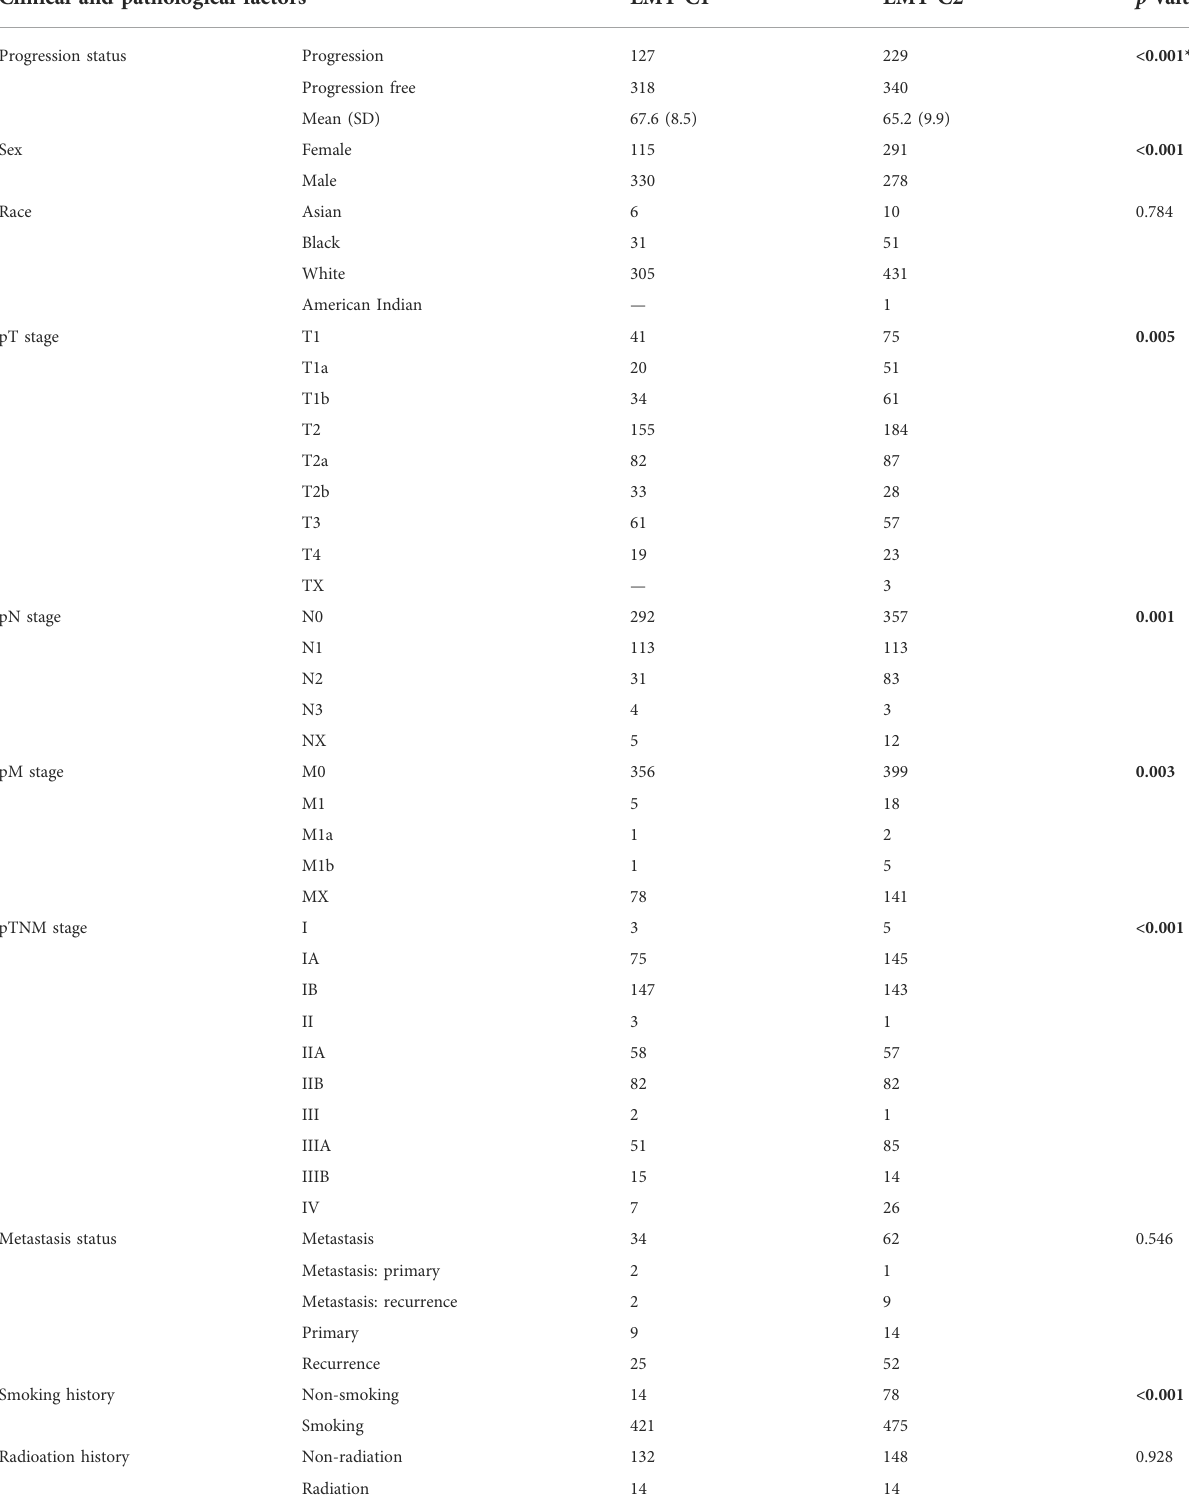
TABLE 1 Clinical and pathological features according to the EMT